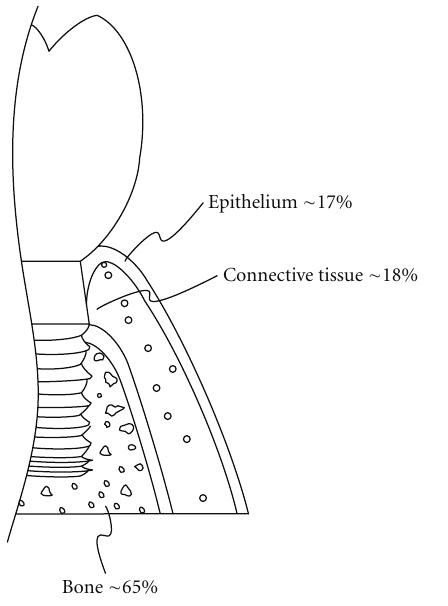
Figure 1: A diagrammatic illustration showing the relationship of the interfacial parts between periodontal tissues and an implant (length: 5.7 mm). The relationship between the bone of the alveolar process, the gingival connective tissue and junctional epithelium are shown, at the level where the implants and tissues